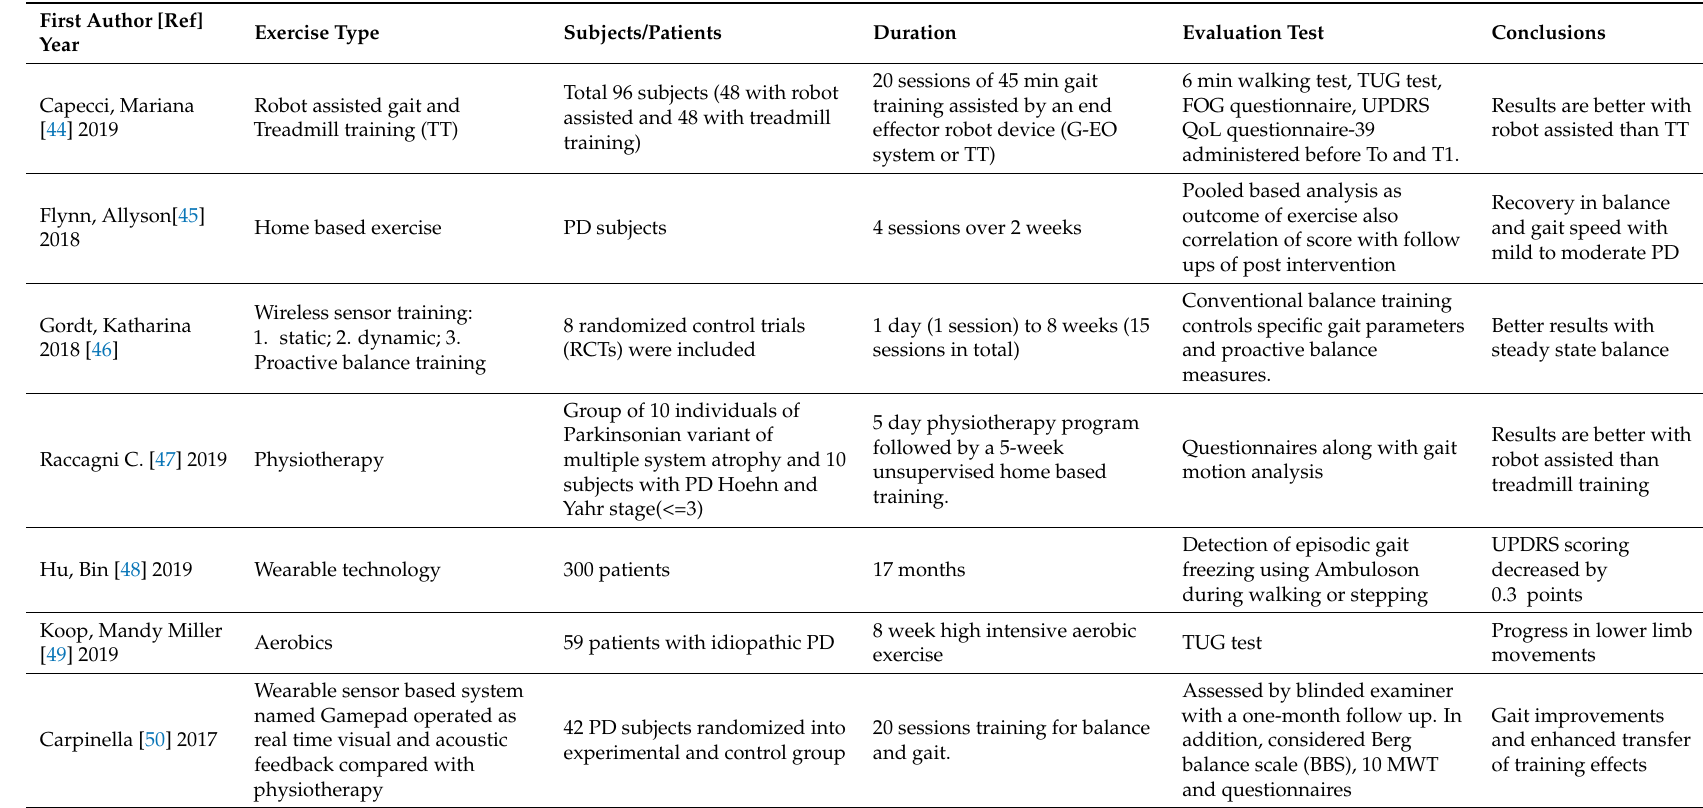
Table 8. Rehabilitation exercises and assessment